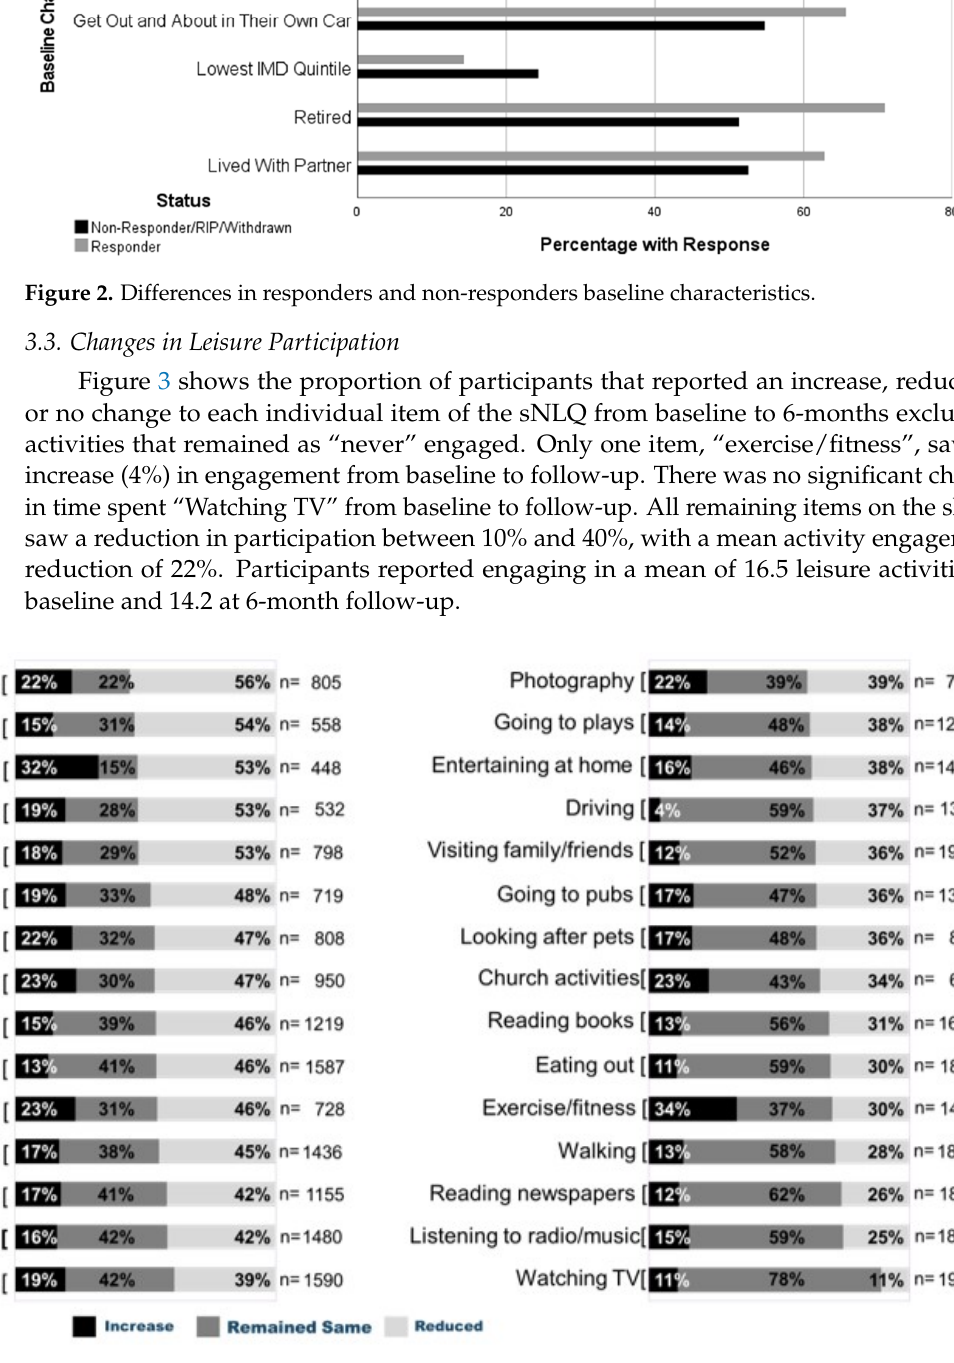
Figure 3. Changes in leisure participation between baseline and 6 months (ordered by highest proportion of reduction in participation).